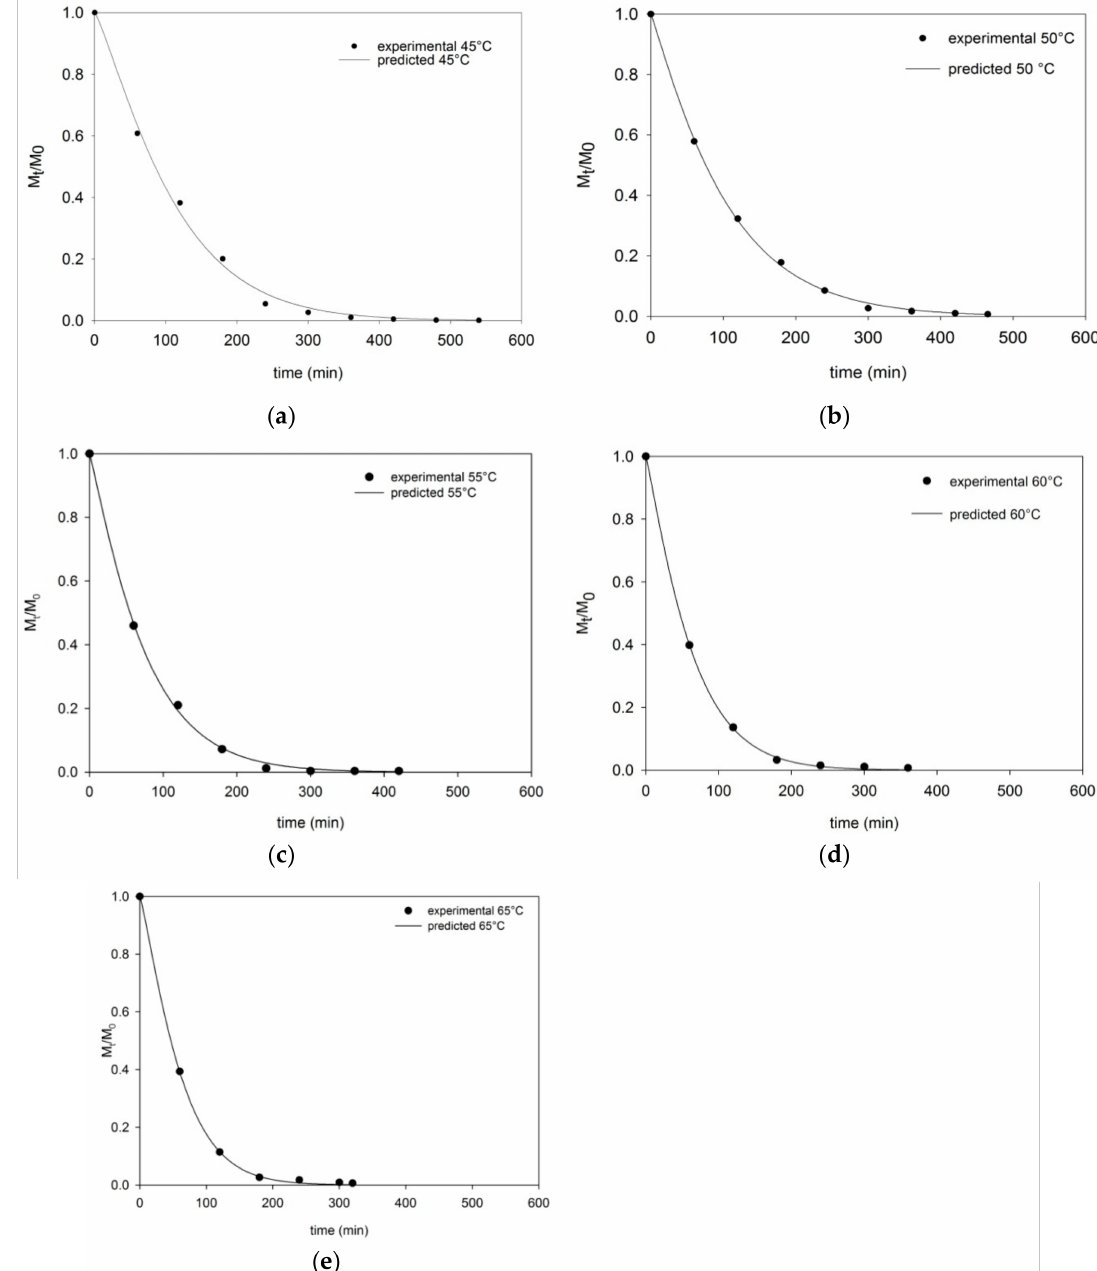
Figure 2. Experimental (symbols) and predicted (lines) drying curves in terms of moisture ratio (M t / M 0 ) of persimmon samples at ( a ) 45 ◦ C, ( b ) 50 ◦ C, ( c ) 55 ◦ C, ( d ) 60 ◦ C, and ( e ) 65 ◦ C The drying times of all samples needed to achieve an equilibrium moisture content ( < 0.05 kg ◦ water / kg db) were 540, 465, 420, 360, and 320 min at 45, 50, 55, 60, and 65 C, respectively. From the investigated temperature range, as expected, these results showed that the drying time is the longest ◦ ◦ at 45 C and shortest at 65 C. In order to predict the water content as a function of drying time, the empirical equations, presented in Table 1, were fitted and statistical parameters and estimated model parameters are shown in Tables 3 and 4,